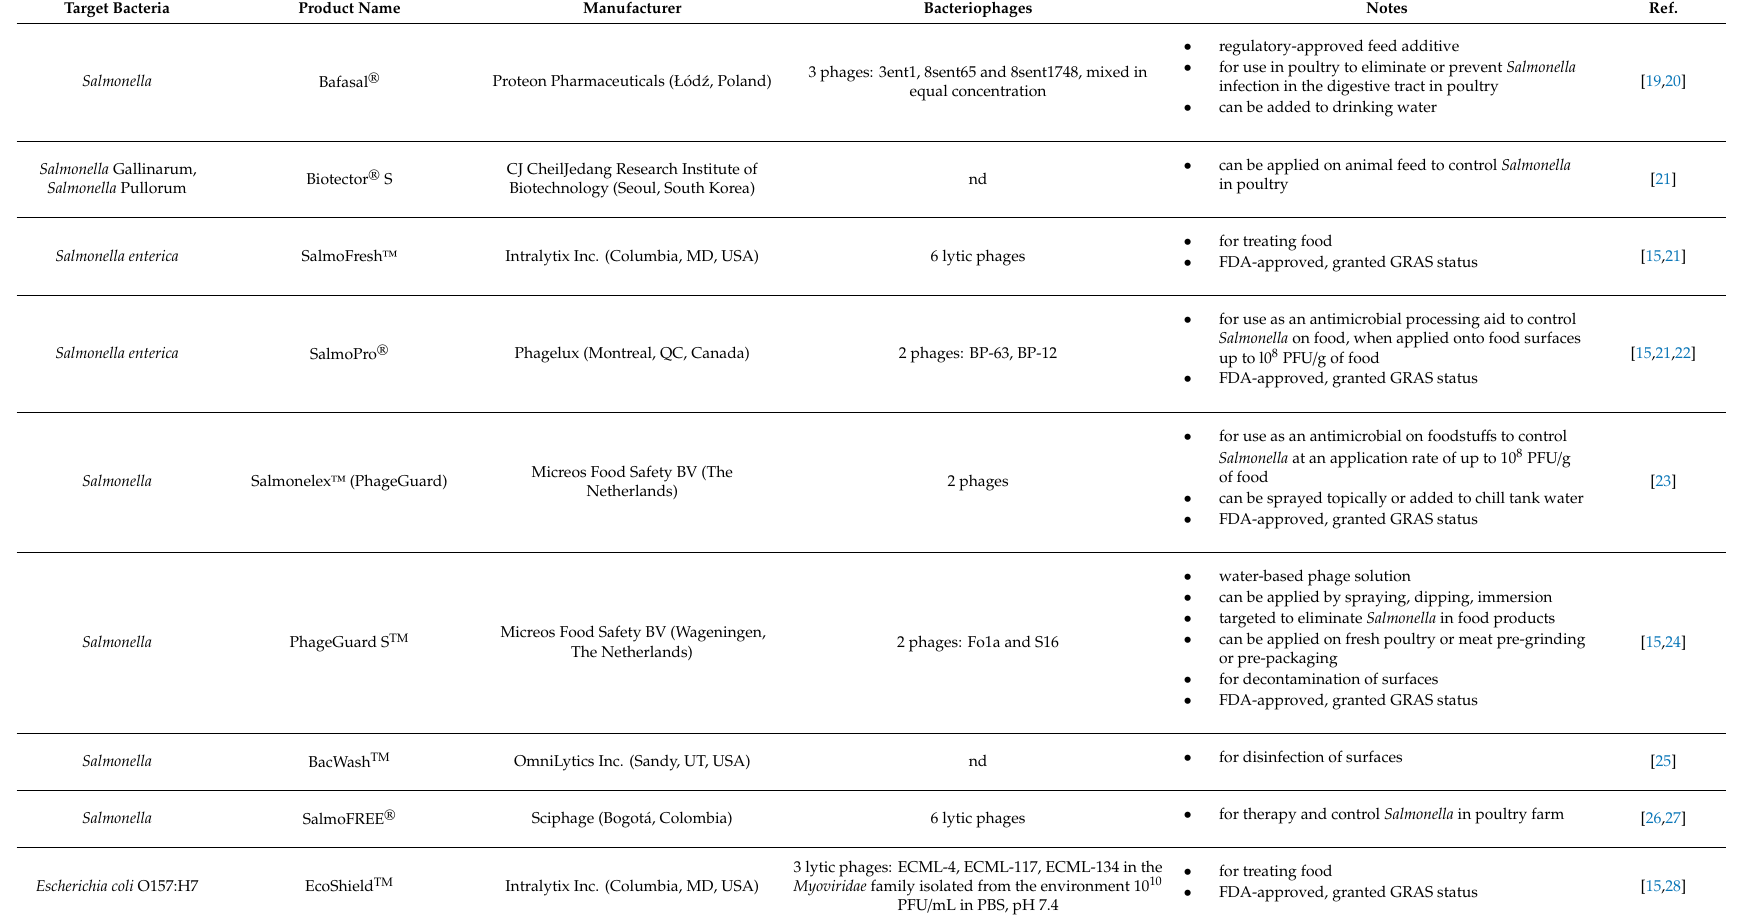
Table 1. Bacteriophage products addressed to the poultry